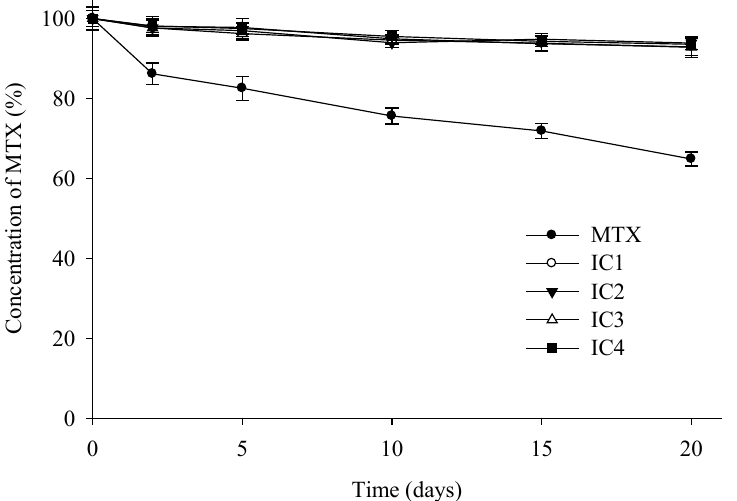
Figure 10. Residual concentration of MTX in inclusion compounds after exposure to forced photo-